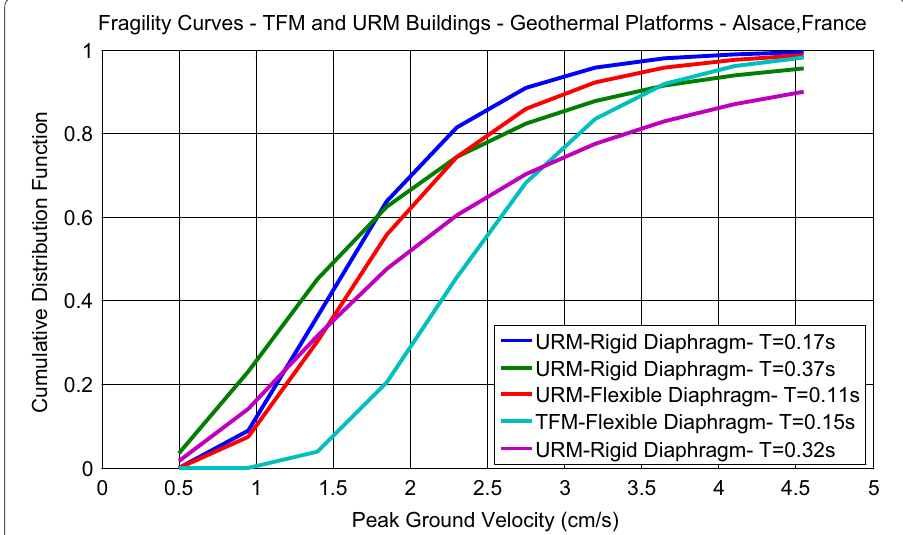
Fig. 13 Proposed analytical fragility curves for first damage state (pre-yielding damage state—DS1—0.1% drift limit for non-structural damage) for unreinforced masonry buildings (URM) and timber-framed masonry buildings (TFM). The buildings are located near the geothermal platforms in Alsace France and are loaded in the weak/short plan view direction of shaking. The fundamental period of these structures was verified with ambient noise measurements through applied sensors (Boxberger et al.